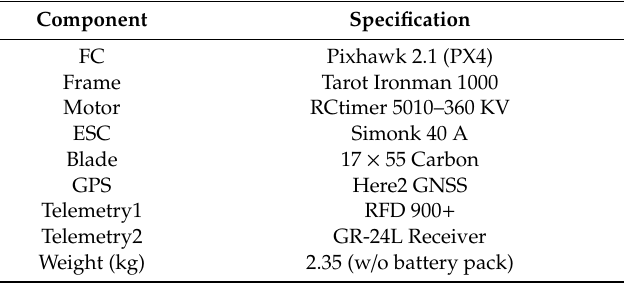
Table 4. Specifications of the UAV.